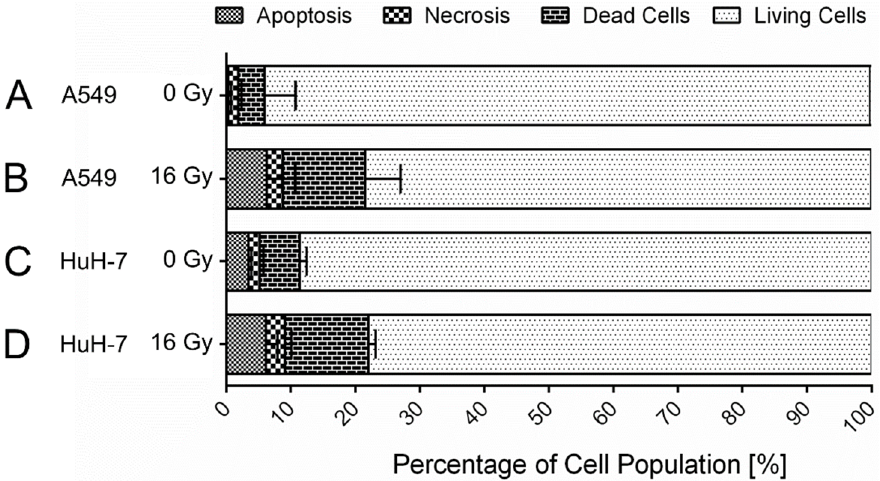
Figure 1. Cell death after 16 Gy gamma-irradiation. Irradiation resulted in a reduction in the viable cell population by ten to fifteen percent in A549 ( p = 0.03) ( A , B ) and in HuH-7 ( p = 0.05) ( C , D ) cells within 72 h. The percentage of living cells in the cell population was decreased to approximately 80% in both investigated cell lines. Shown are mean values ± SD, unpaired, two-tailed t-test, comparison between untreated control cells and irradiated cells of the respective cell line, N ≥ 3. The tumor cells that were able to withstand 16 Gy gamma-irradiation experienced an arrest of their cell cycle in the G2 phase (Figure 2). Both tumor cell lines showed signifi- cantly increased cell numbers in the G2 phase within one day after irradiation. Simulta- cells in the G2 phase doubled from 31% to 59% in A549 cells. In HuH-7 cells, the effect